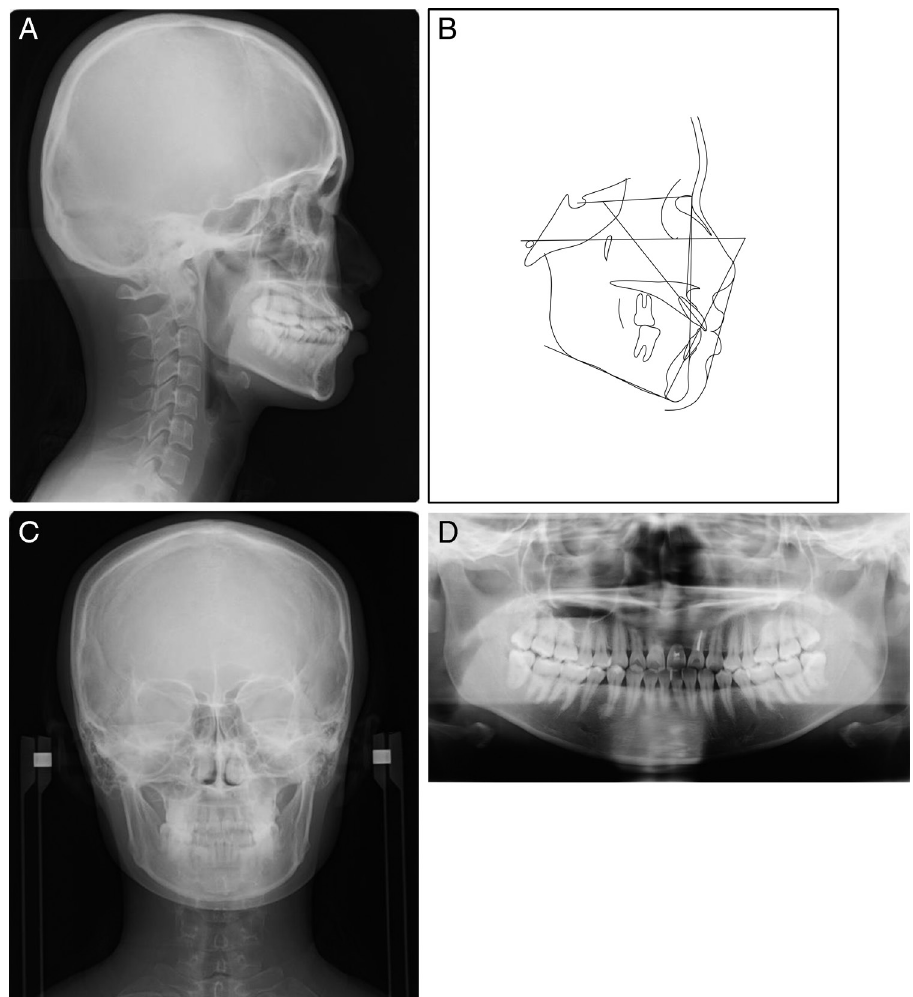
Figure 3. Pretreatment cephalograms, a tracing of lateral cephalogram and a panoramic radiograph. (A) Lateral cephalogram. (B) Tracing. (C) Posteroan- terior cephalogram. (D) Panoramic